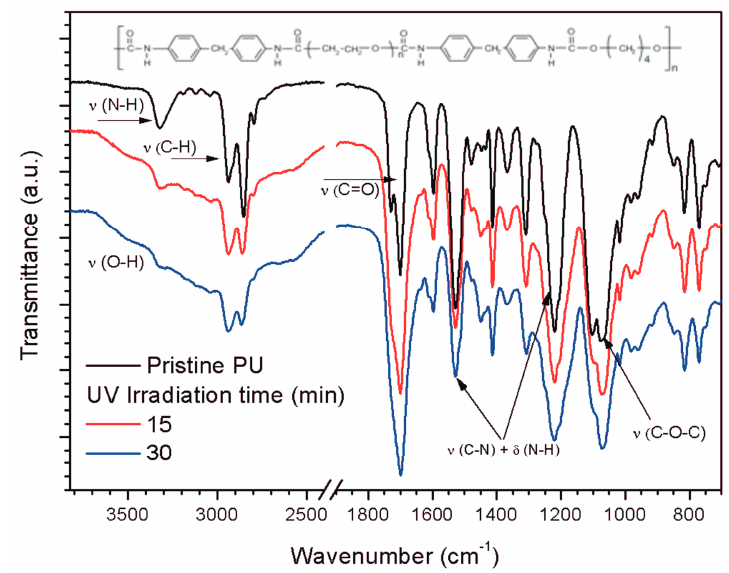
Figure 2. Fourier transform infrared spectroscopy in attenuated total reflection mode (FTIR-ATR) spectra of pristine PU films and treated ones with UV irradiation in the presence of acrylic acid (AA) vapors for different times. The spectra were slightly moved in the vertical direction for better presentation. The molecular structure of the polyurethane studied here is shown at the top of the figure.